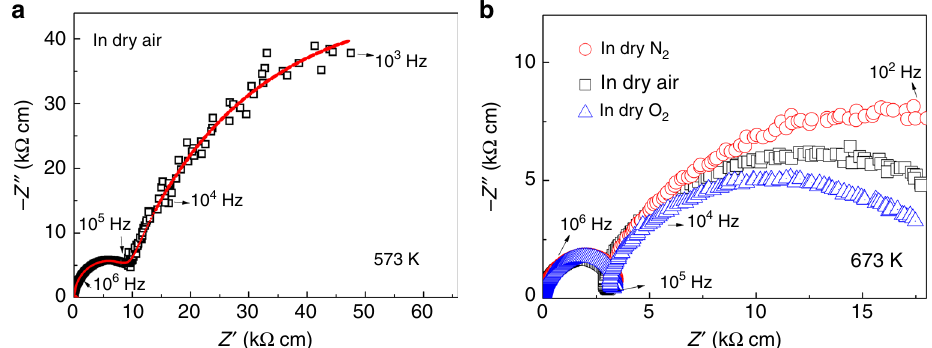
Fig. 2 Complex impedance plots of CsBi 2 Ti 2 NbO 10 − δ . a Complex impedance plots recorded in fl owing dry air at 573 K on heating. Red line indicates the equivalent circuit fi tting. The equivalent circuit used to model the impedance data and complex impedance plots at different temperatures are shown in Supplementary Fig. 7. b Complex impedance plots measured in fl owing dry N 2 , air, and O 2 gases at 673 K